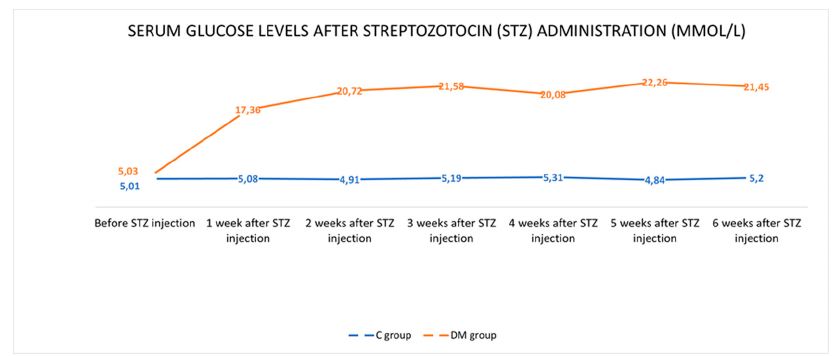
Figure 1. Serum glucose levels in control and diabetic pigs during the experiment .